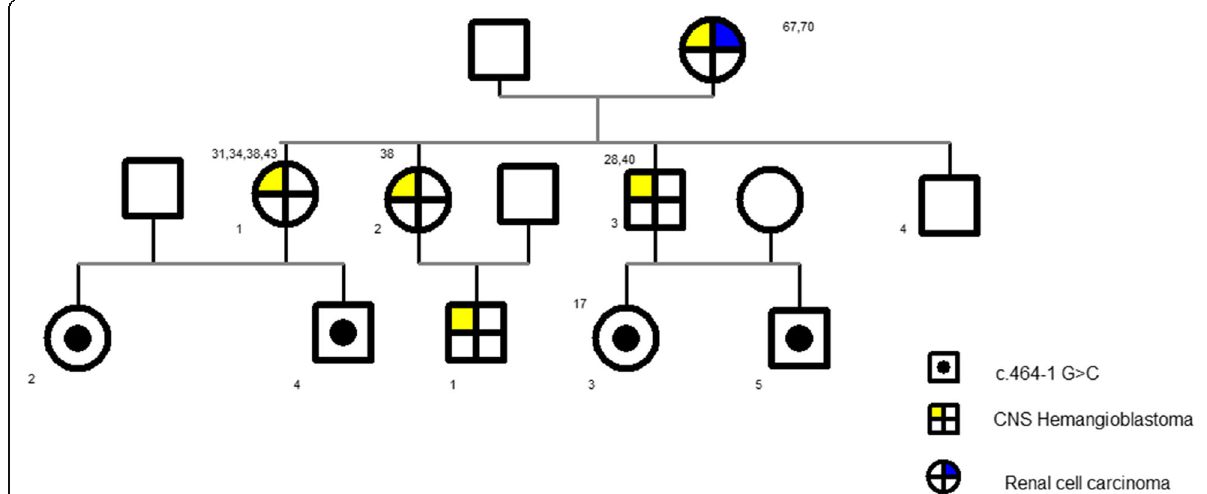
Fig. 4 Family tree of the patients with c.464-1G > C point mutation. Three-generation pedigree of the patient family showing that the synonymous VHL variant c.464-1G > C segregates with affected family members. The number on the upper left corner of each patient with VHL- associated HGBs indicates the age of each operation for CNS